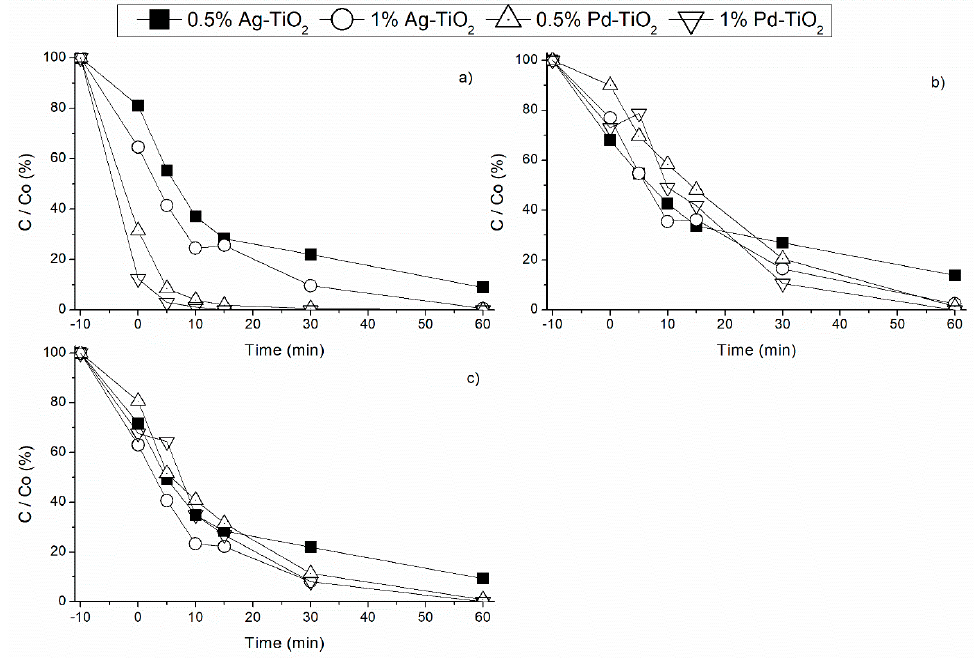
Figure 9. Contaminants’ (( a ) SMX, ( b ) CBZ and ( c )—LRZ) normalized concentrations during photocatalytic oxidation under sunlight radiation.